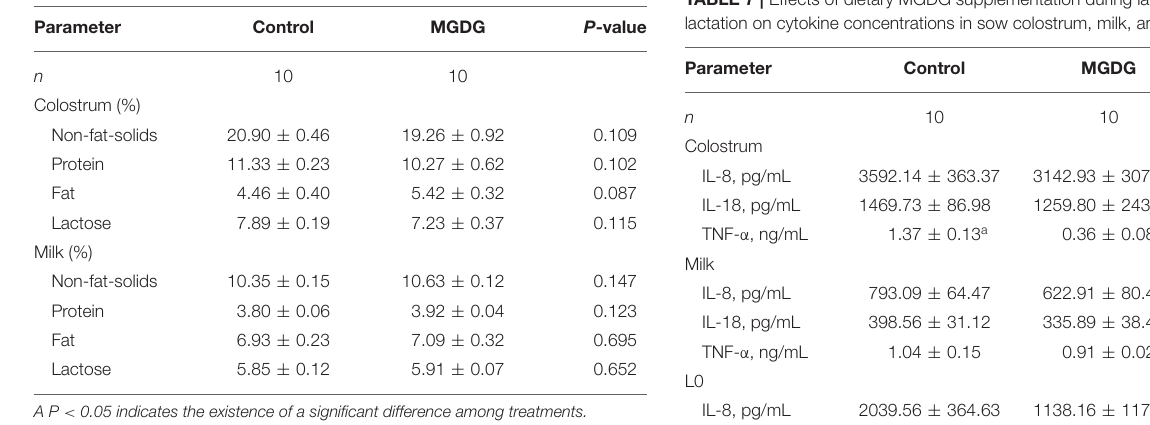
TABLE 7 | Effects of dietary MGDG supplementation during late gestation and lactation on cytokine concentrations in sow colostrum, milk, and